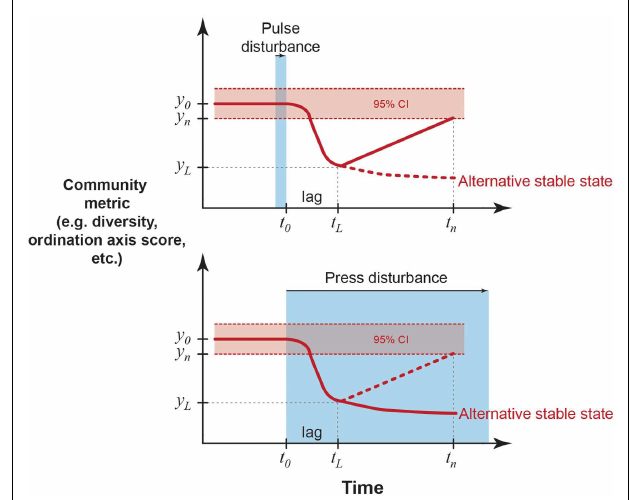
FIGURE 1 | Examples of quantitative definitions of resistance and resilience from ecology (Westman, 1978; Orwin andWardle, 2004; Suding et al., 2004). A microbial community parameter of interest has a mean value of y 0 and temporal variance, illustrated here by a 95% confidence interval around the mean (though other quantifications of variance, such as standard deviation or variance ratios may be used). A pulse disturbance ends (or a press disturbance begins) at time t 0 and the parameter changes by | y 0 − y L | after a time lag t L − t 0 . Resistance (RS) is an index of the magnitude of this